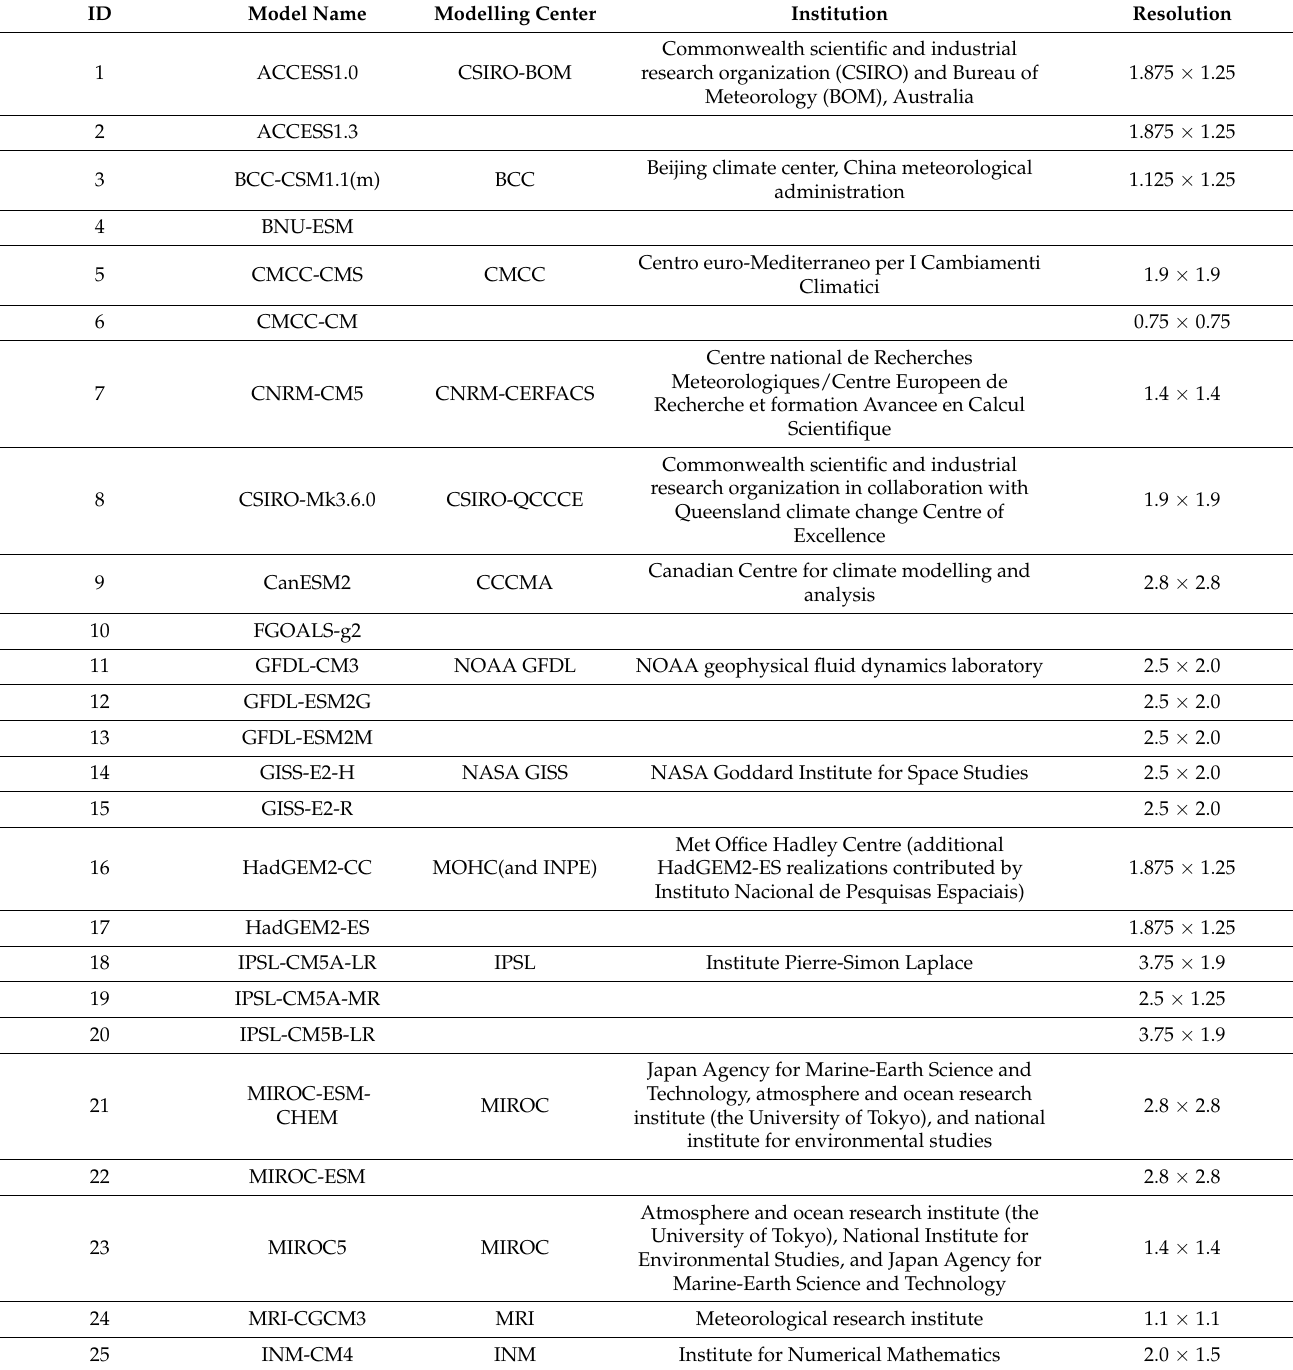
Table 1. Detailed information about